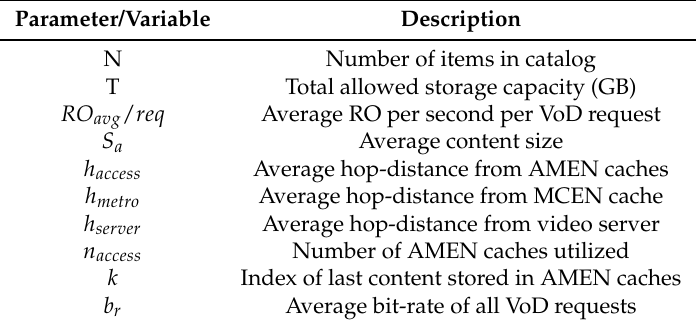
Table 1. Notation considered in the analytical